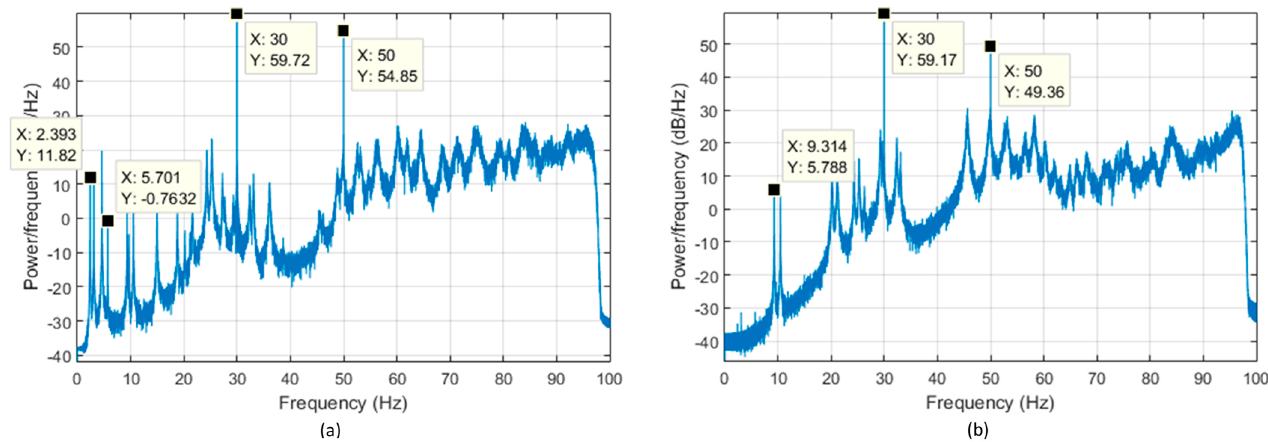
Figure 15. Estimated PSD of Sensor 1 of the pure data. ( a ) Channel X. ( b) Channel Z.